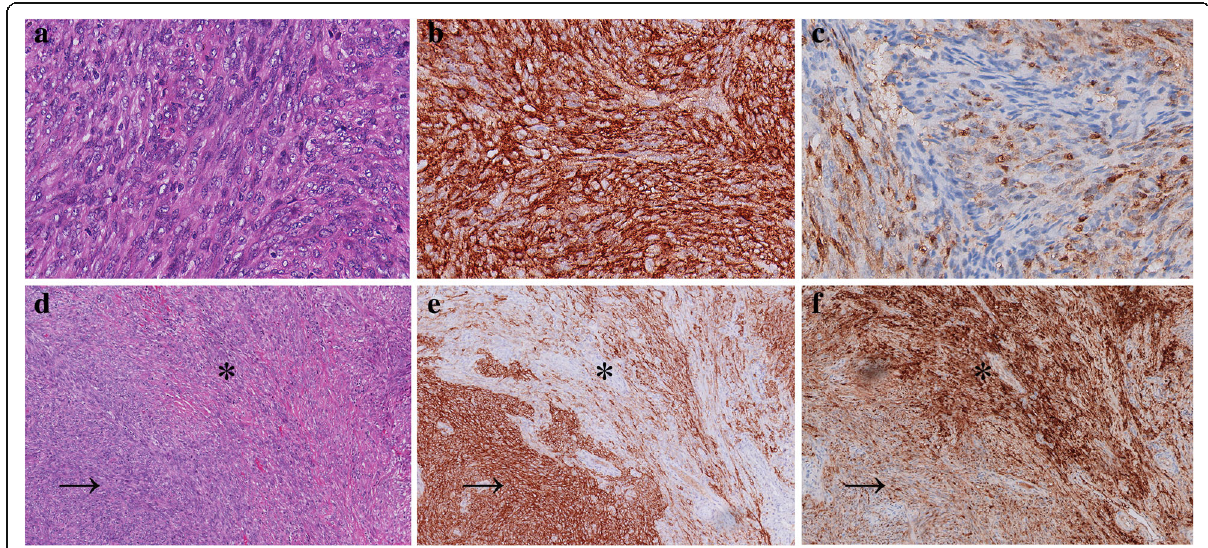
Fig. 4 Histological and immunohistochemical characteristics of the hypercellular areas. a . The spindle cells arranged in a fascicular or storiform growth pattern. Focally, cells have a streaming or syncytial pattern. Haematoxylin-eosin staining, 400x magnification. b-c. EMA ( b ) and S100( c ) expression was detected. Most spindle cells showed EMA+/S100- staining, only scattered cells exhibited the opposite expression pattern. Immunohistochemical staining, 400x magnification. d . The hypercellular (black arrow) areas and the surrounding hypocellular areas(black asterisk) formed a vague boundary at low magnification. Haematoxylin-eosin staining, 200x magnification. e - f . The boundaries between hypercellular (black arrow) and hypocellular (black asterisk) area were demonstrated by non-overlapping expression of EMA ( e ) and S100 ( f ) in the same field as Fig. 4d. Immunohistochemical staining, 200x